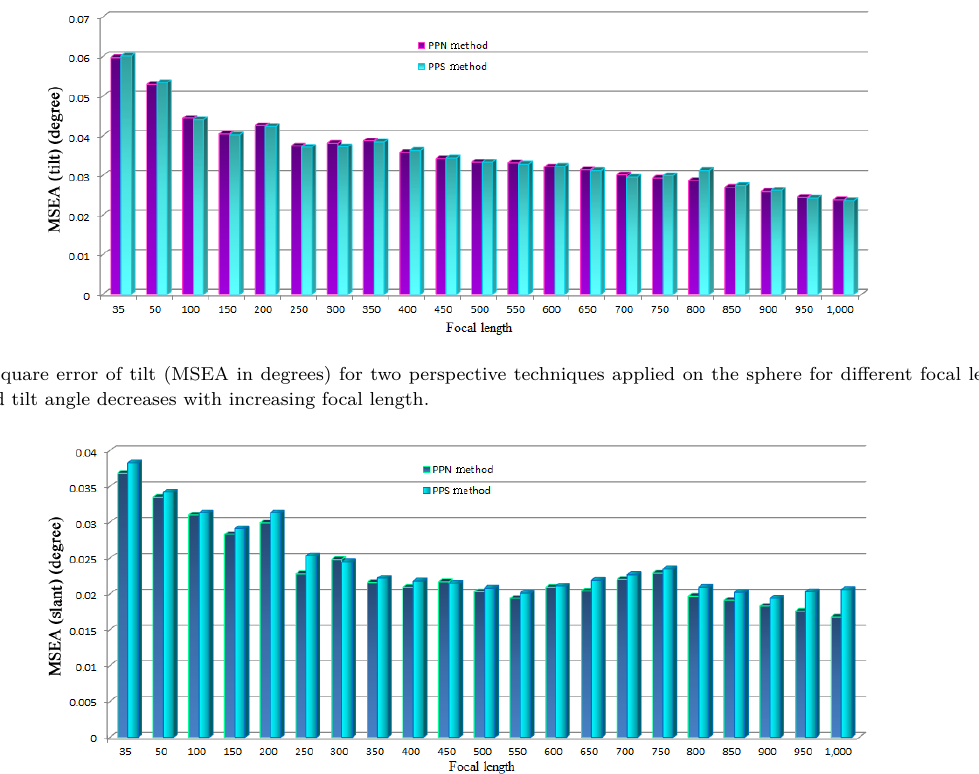
Fig. 10 Mean square error of slant (MSEA in degrees) for two perspective techniques applied on the sphere for different focal lengths. The error is decreasing with gradually increasing focal length. PPN perspective projection yields more decrease than the PPS perspective technique.